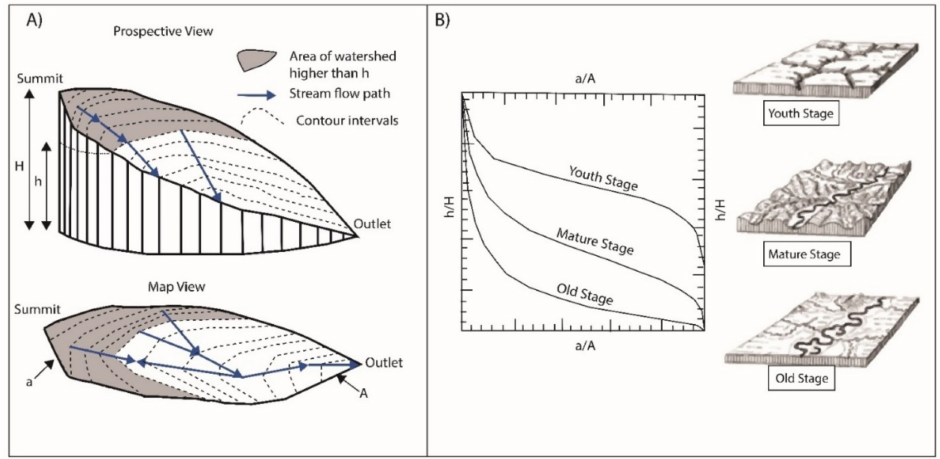
Figure 7. The basic concept of hypsometric curves and their interpretation curves [36]. ( A ) The schematic design explains the method for measuring hypsometric curves using percent height (h/H) and percent area relationship (a/A). ( B ) Stages of the geomorphic evolution of the drainage basin